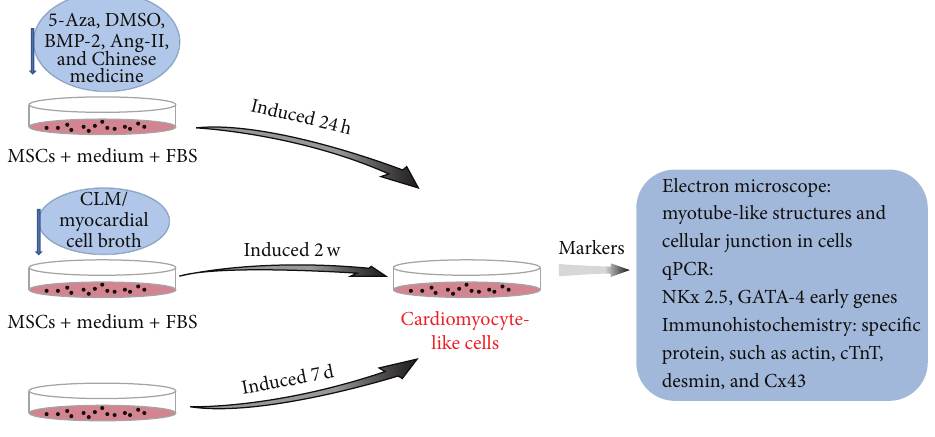
Figure 1: The diagram for the induction and identification of cardiomyocyte-like cells. MSCs cultured in medium supplemented with 5-Aza, DMSO, and BMP-2 will be induced to cardiomyocyte-like cells 24 h later. MSCs incubated in CLM/myocardial cell broth will differentiate to cardiomyocyte-like cells after 2 w. MSCs cocultured with cardiomyocyte will differentiated to cardiomyocyte-like cells 7 d later. The identification methods consist of morphology detection and molecular marker